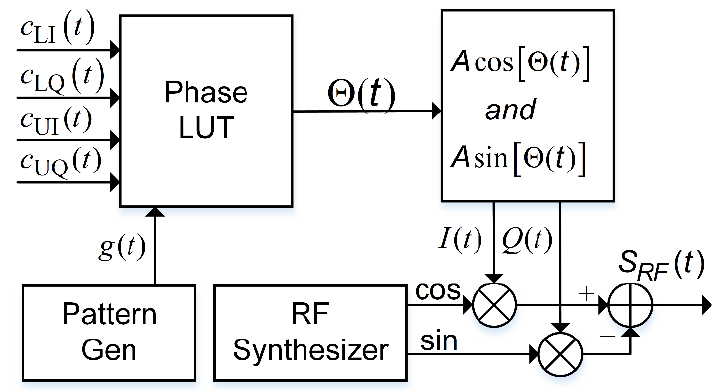
Figure 5. Phase rotation generation.